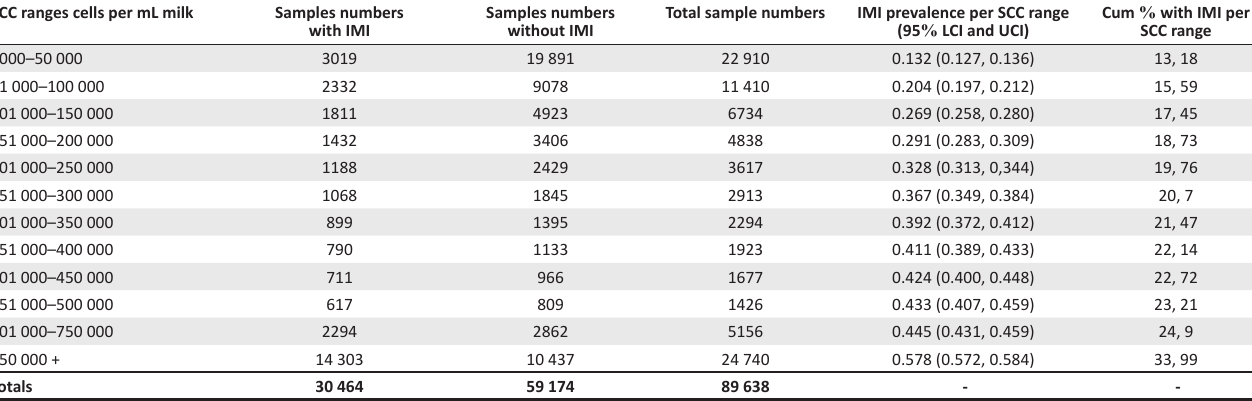
TABLE 3: Quarter milk samples indicating the presence and absence of intramammary infection for each somatic cell count range. SCC ranges cells per mL milk Samples numbers Samples numbers with IMI without IMI